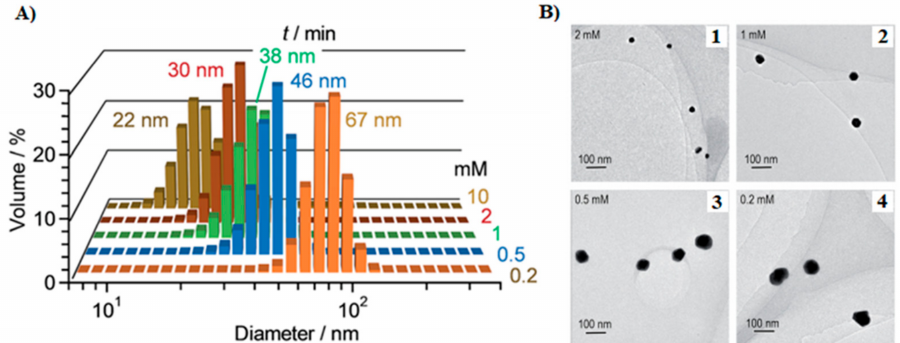
Figure 3. ( A ) Hydrodynamic diameter of Au NPs obtained under 254 nm UV irradiation in the presence of citric acid, at different concentrations, as the reductant and stabilizing agent. ( B ) TEM of Au NPs obtained under xenon lamp (254 nm, 150 mW m − 2 ) irradiation for 100 min and different concentrations of citric acid: (1) 2.0 mM, (2) 1.0 mM, (3) 0.5 mM, and (4) 0.2 mM. In the presence of higher concentrations of citric acid, very stable Au NPs with small size are obtained.